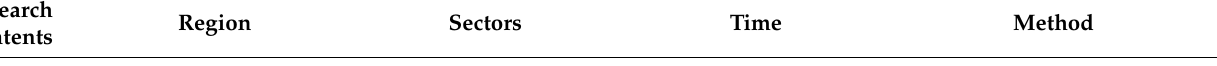
Table 1. A Summary of studies on economic impacts of China’s